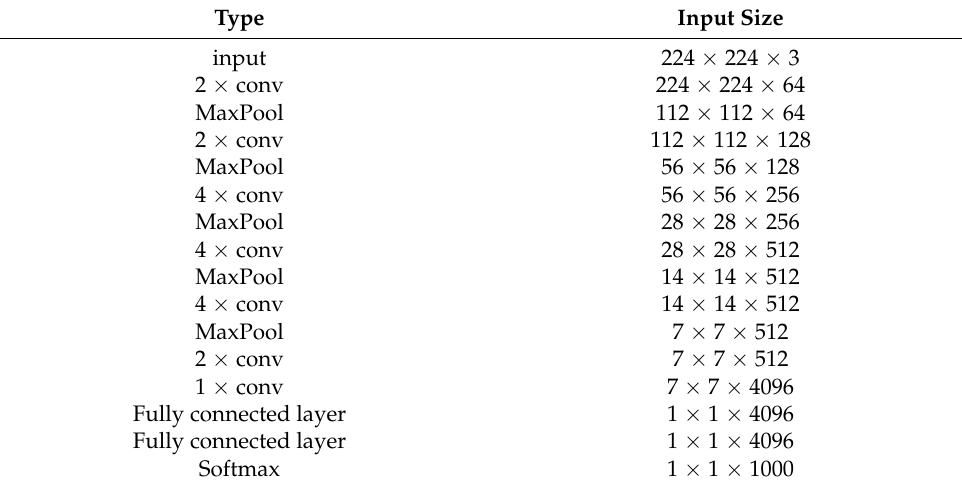
Table 2. A summary of the VGG-19 architecture in terms of input size requirements for every layer of the network.